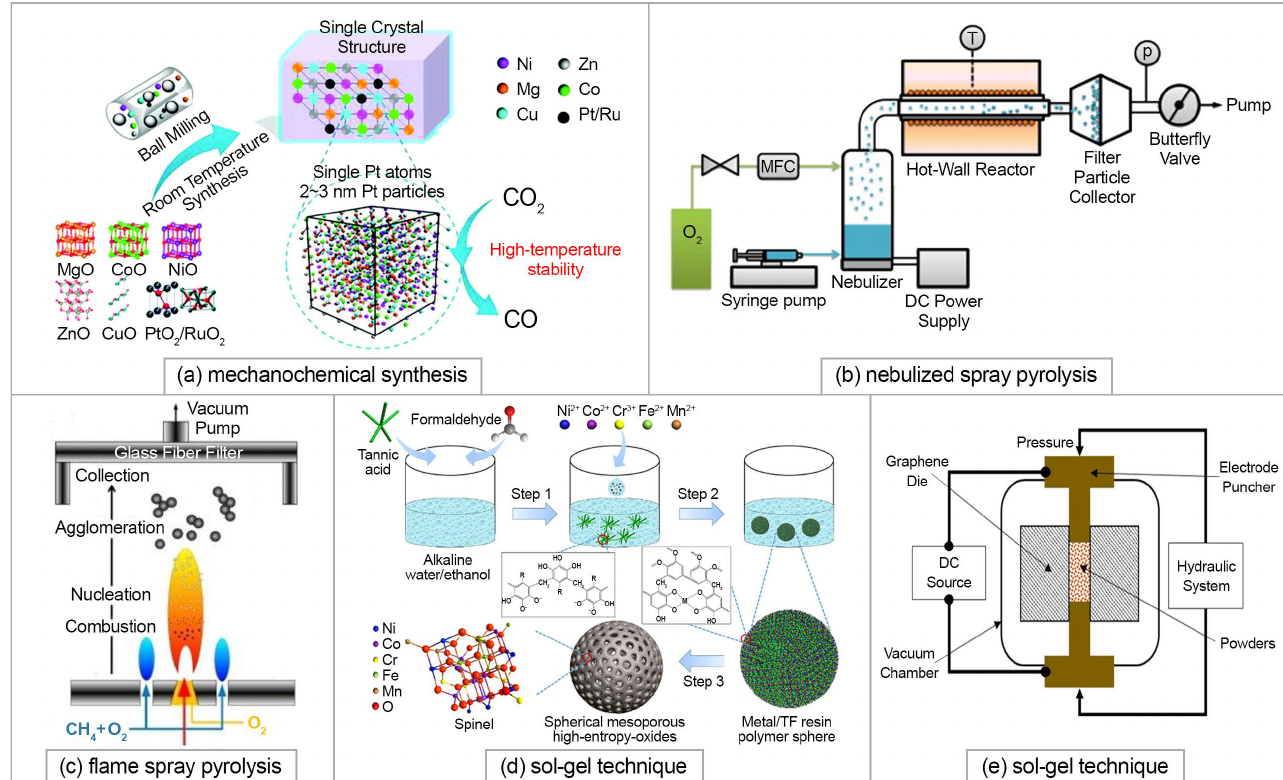
Figure 10. Various HEOs synthesis techniques: ( a ) mechanochemical synthesis; ( b ) nebulized spray pyrolysis; ( c ) flame spray pyrolysis; ( d ) sol–gel technique; ( e ) spark plasma sintering (( a ) is reprinted with permission from [113], Copyright (2019) American Chemical Society; ( b ) is adopted from [115] with permission of Elsevier; ( c ) is adopted from [116] with permission of Royal Society of Chemistry; ( d ) is reprinted with permission from [117], Copyright (2020) American Chemical Society; ( e ) is adapted with permission from [28], Copyright (2020) American Chemical Society).